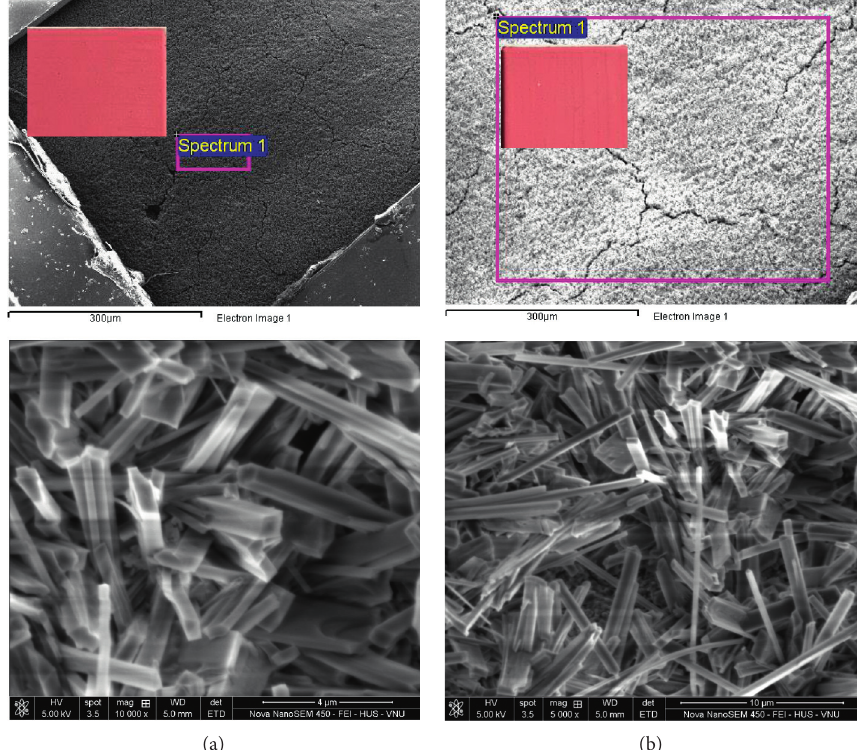
Figure 5: SEM image results of the silicate coating film (curing at 20 days) on the steel plate before (a) and after heating at 1000 ° C